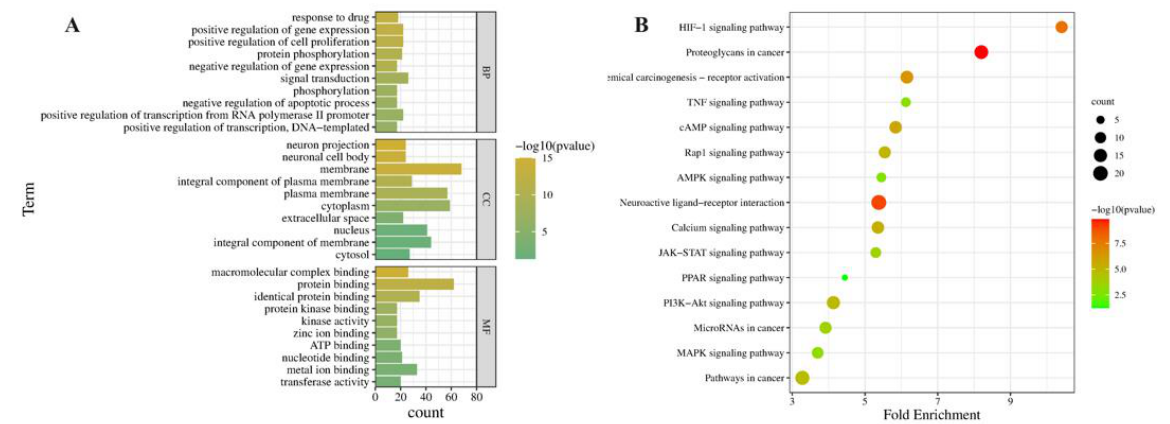
Figure 9. GO and KEGG enrichment analysis of potential targets for EEP antioxidative mechanism against hyperthyroidism of EEP. ( A ) bar chart of GO analysis, ( B ) bubble chart of KEGG pathways.